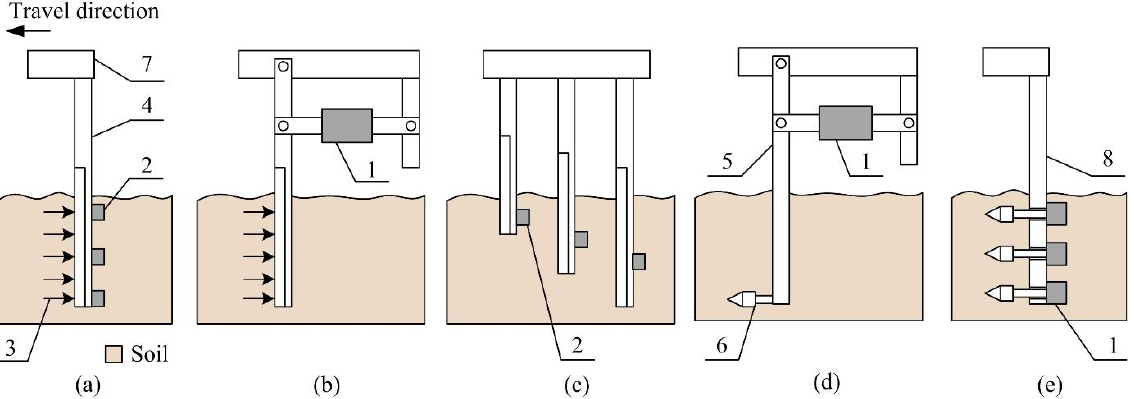
Figure 1. Location of various sensors for measurement of soil mechanical resistance depending on the device design: ( a ) Strain gauges on the cutting blade; ( b ) Load cell connected with the cutting blade; ( c ) Multiple strain gauges on cutting blades; ( d ) Load cell and lever with penetrating cone; ( e ) Multiple load cells with penetrating cones: 1 — load cell; 2 — strain gauge; 3 — soil resistance force; 4 — cutting blade; 5 — force lever; 6 — penetrating cone; 7 — frame; 8 — shin. This study presents the on-the-go measurement system of soil mechanical resistance.